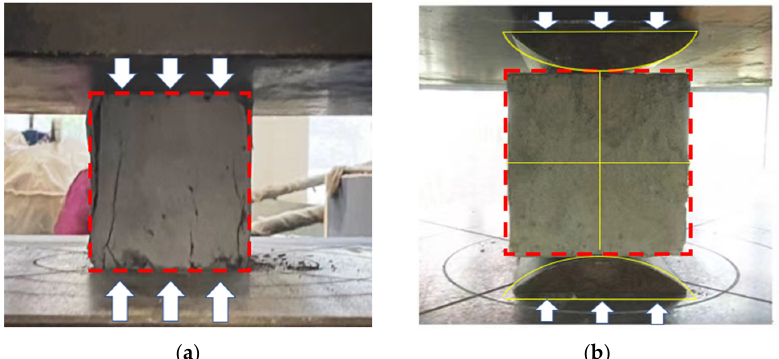
Figure 2. Static mechanical performance test: ( a ) Cube compression test; ( b ) cube split test.